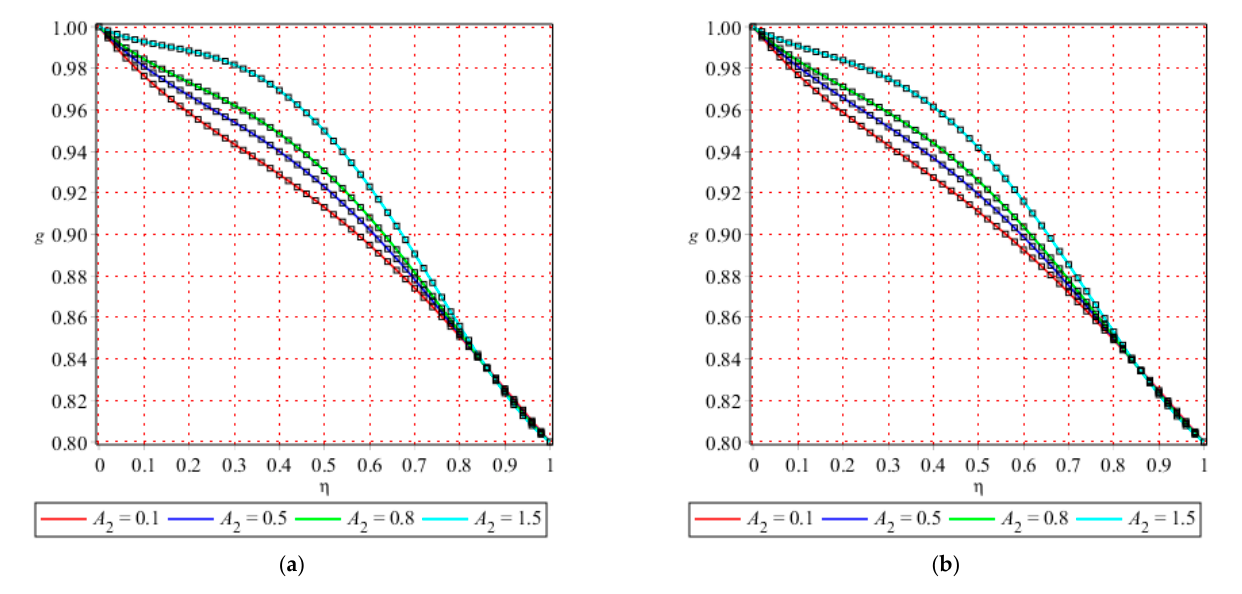
Figure 8. Influence of A 2 on g ( η ) . ( a ) SWCNTs , ( b ) MWCNTs . Table 1. Thermo-physical properties of water and carbon nanotube. Thermophysical